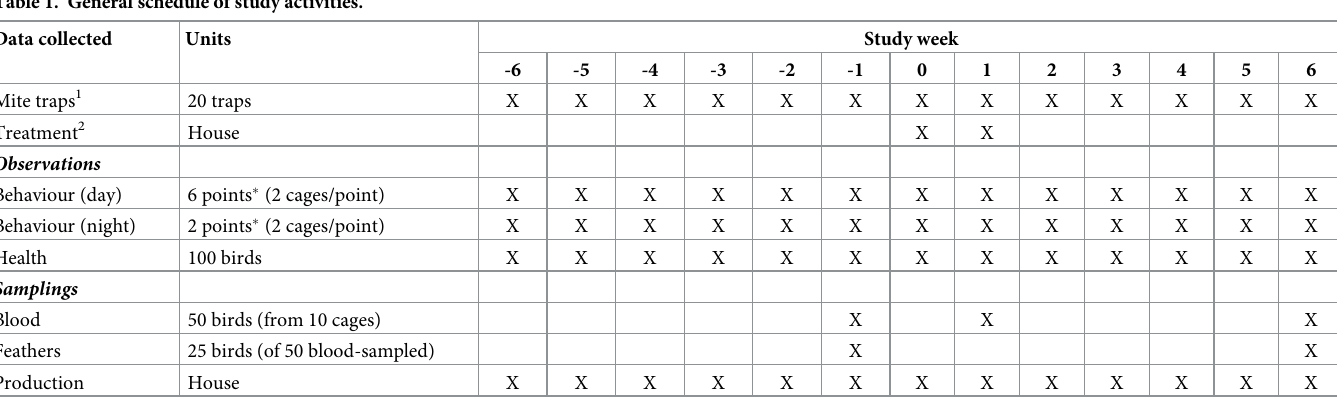
Table 1. General schedule of study